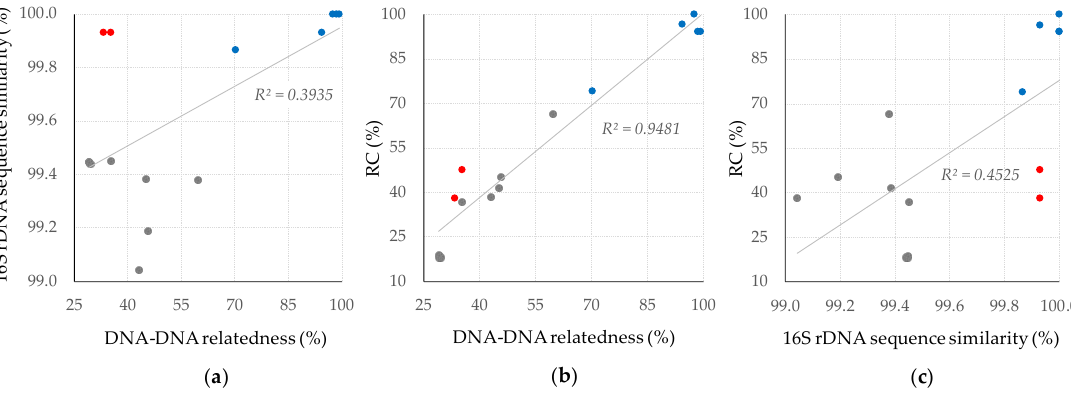
Figure 3. Relationship among 16S rDNA sequence similarity, DNA–DNA relatedness, and rate of PKS and NRPS gene clusters conserved (RC) between Streptomyces strains. ( a ) Relationship between 16S rDNA sequence similarity and DNA–DNA relatedness; ( b ) Relationship between RC and DNA–DNA relatedness; ( c ) Relationship between RC and 16S rDNA sequence similarity. RC was calculated as stated in the Materials and Methods section. Blue, the same species (or the same genomospecies); red, different species with 16S rDNA sequence similarity of >99.9%; grey, different species with 16S rDNA sequence similarity of <99.5%. Data were taken from the following strain pairs: blue from Streptomyces